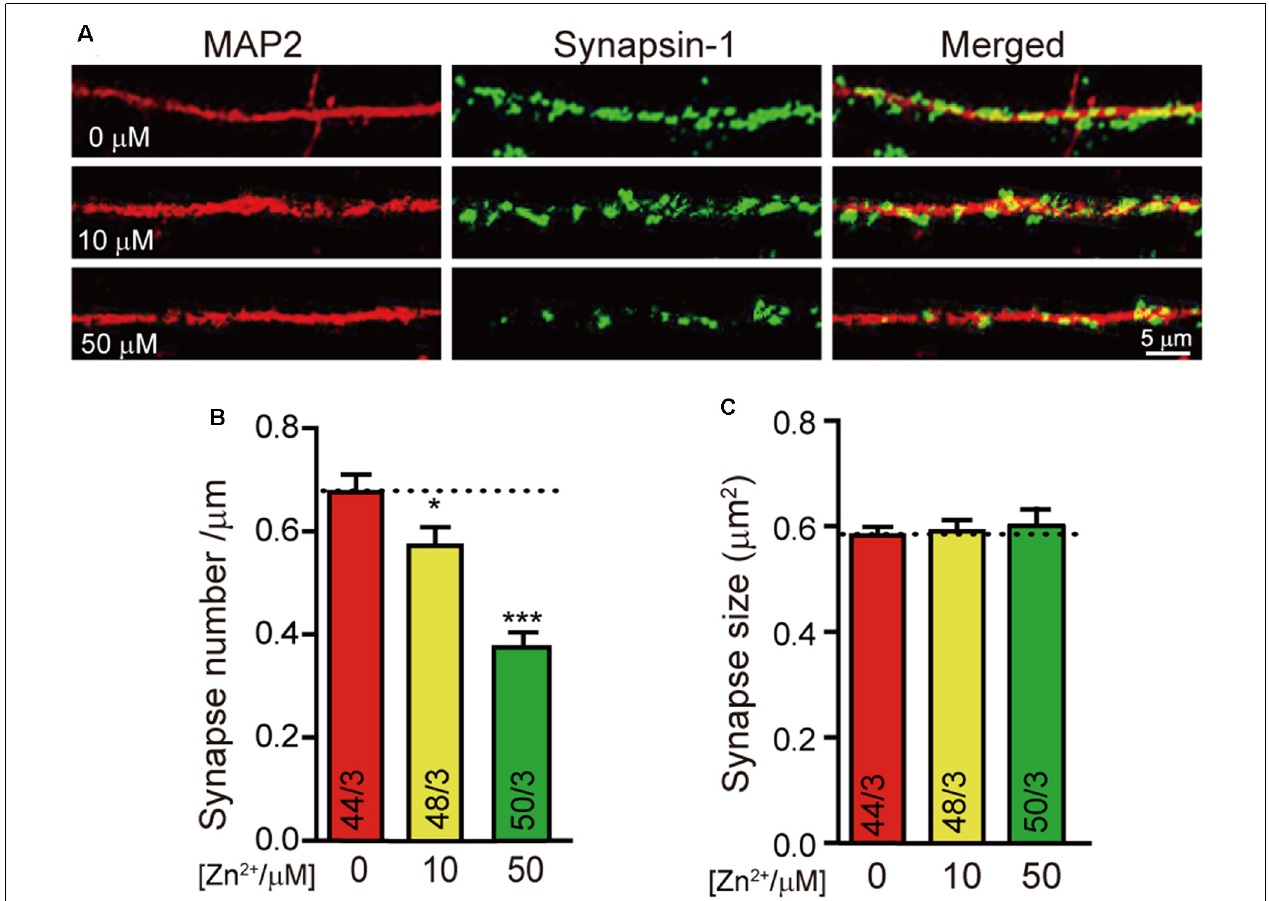
FIGURE 1 | Higher concentration of Zn 2+ decreases the synapse formation of cultured neurons. (A) Representative images of neurons cultured with 0 µ M/10 µ M/50 µ M Zn 2+ were fixed and labeled by synapsin1 (to mark synapses) and MAP2 antibodies (to mark dendrites). The scale bar in the right lower corner applies to all images. (B,C) Summary graphs of synapse number (the number of synapsin1-specific puncta) and synapse size (the area of synapsin1-specific puncta) for all conditions as described in (A) . Data information: numbers of cells/independent cultures analyzed are listed in the bars. Data shown in summary graphs are mean values ± SEM. Statistical significance was analyzed by Student’s t -test. * p < 0.05; *** p < 0.001. Scale bar: 5 µ